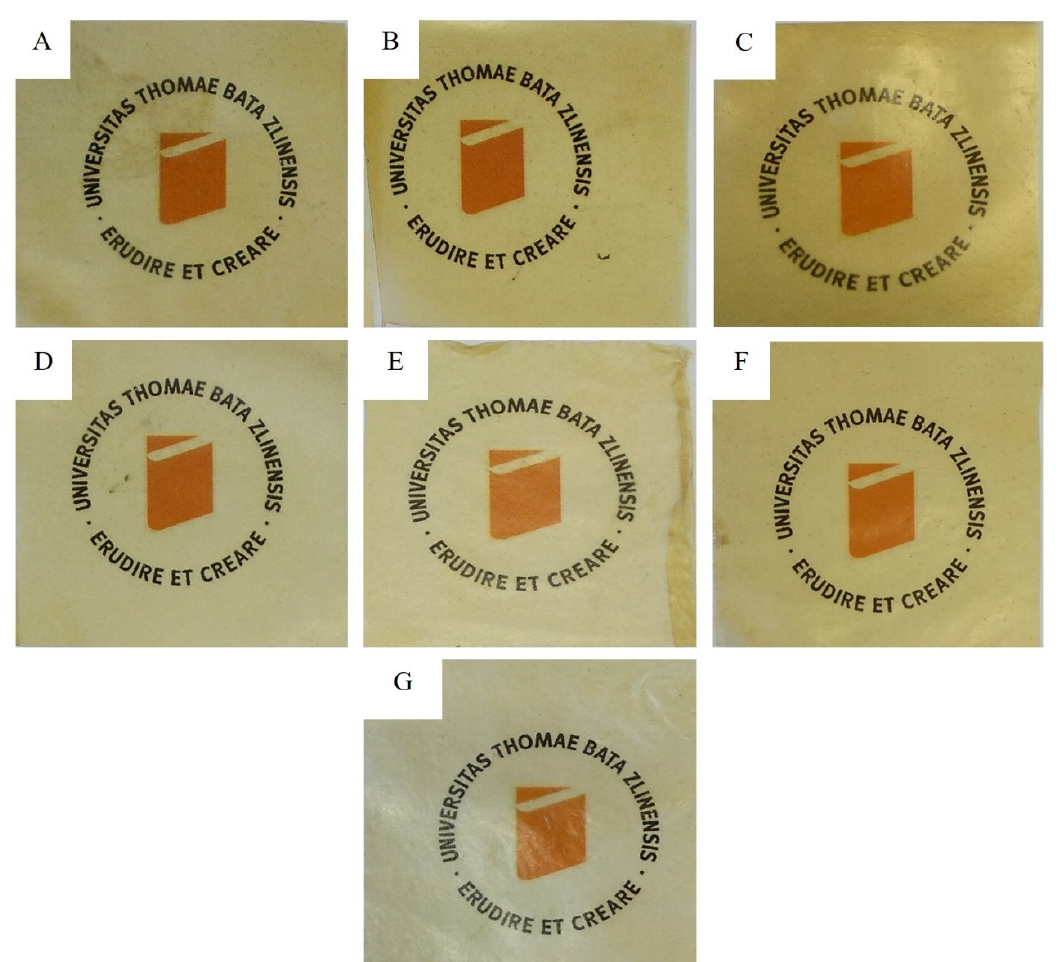
Figure 1. The films ( A – G ) after heat pressing placed over Univerzita Tomáše Bati ve Zlín ě logo to show real transpar-